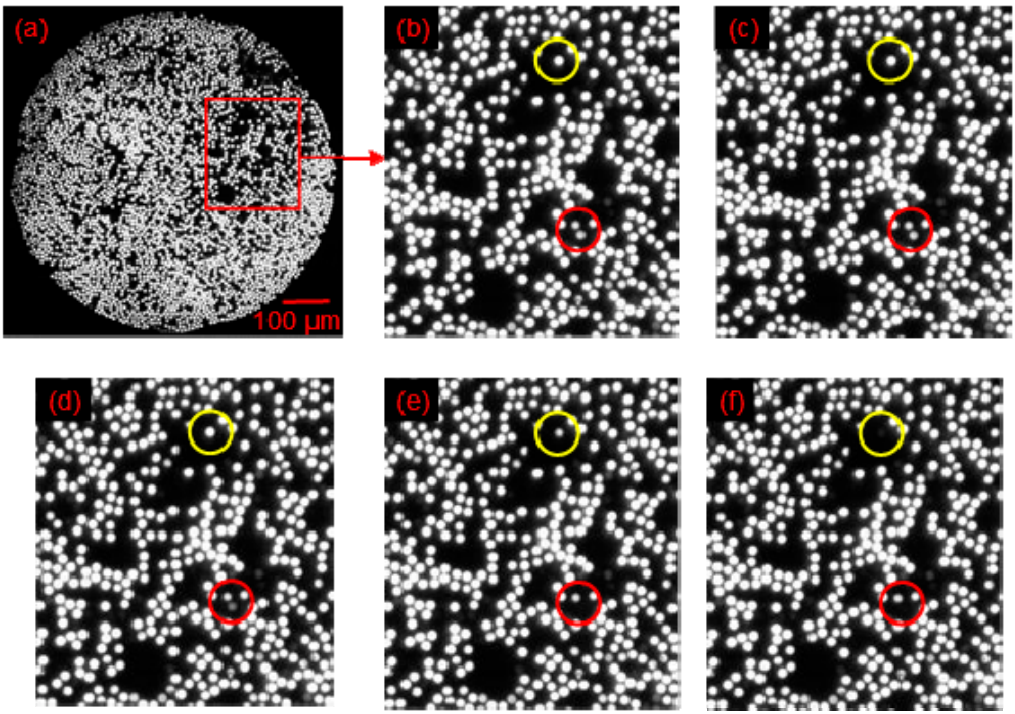
Figure 10. Demonstration of the sequential fibre failure in the SDOF self-sensing composite: ( a ) image captured by the high-speed camera with a highlighted section where the filaments fractured sequentially; ( b ) magnified view of the section with two fibres highlighted with red and yellow circles that are about to fracture; ( c ) image captured after 16.67 milli-seconds showing the attenuated light in the fibre shown within the red circle; ( d ) the fibre within the red-circle is about to fracture; ( e ) the fibre within the red circle was fractured whilst the light was attenuated for the fibre within the yellow-circle i.e. , it is about to fracture; and ( f ) both the highlighted filaments have fractured and thus stopped transmitting light.